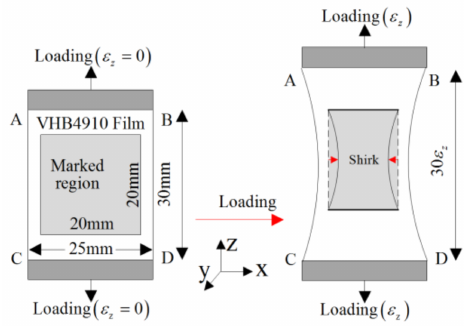
Figure 7. Illustration of VHB 4910 specimen under tension test